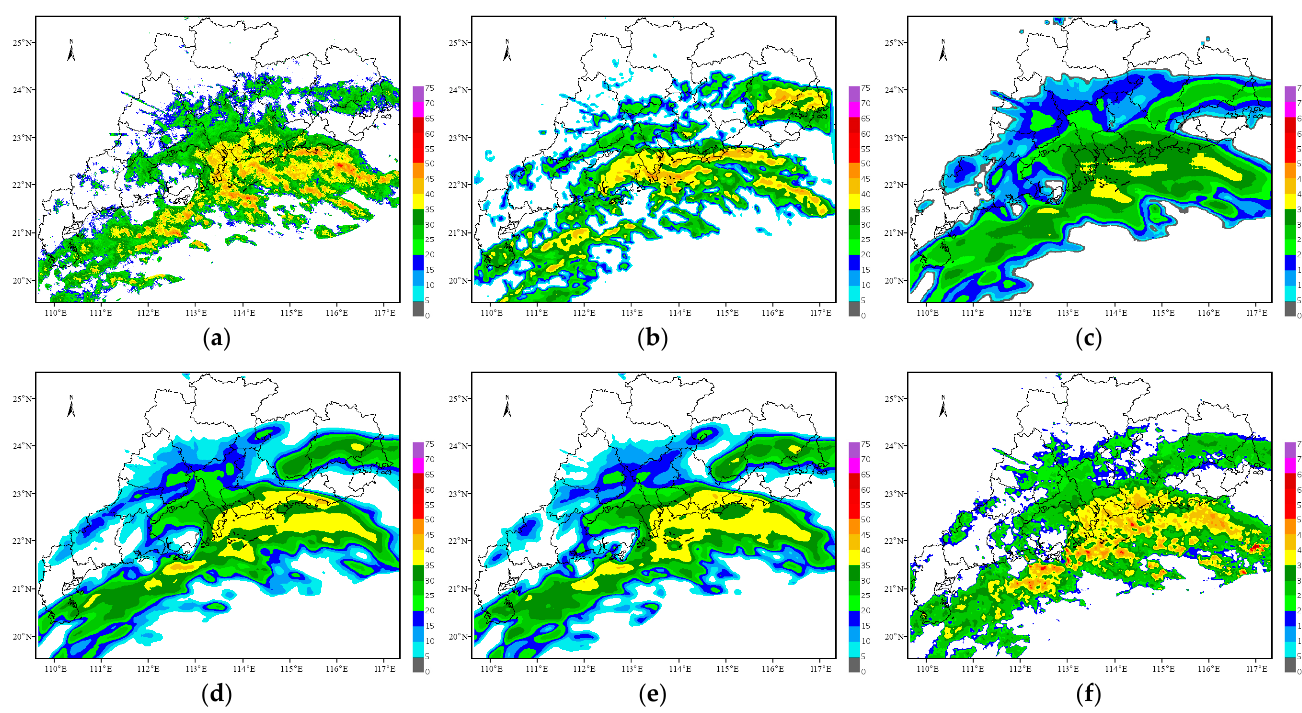
Figure 11. Nowcasting results of the typhoon process for the next 1 h. ( a ) Observation; ( b ) Opticalflow;